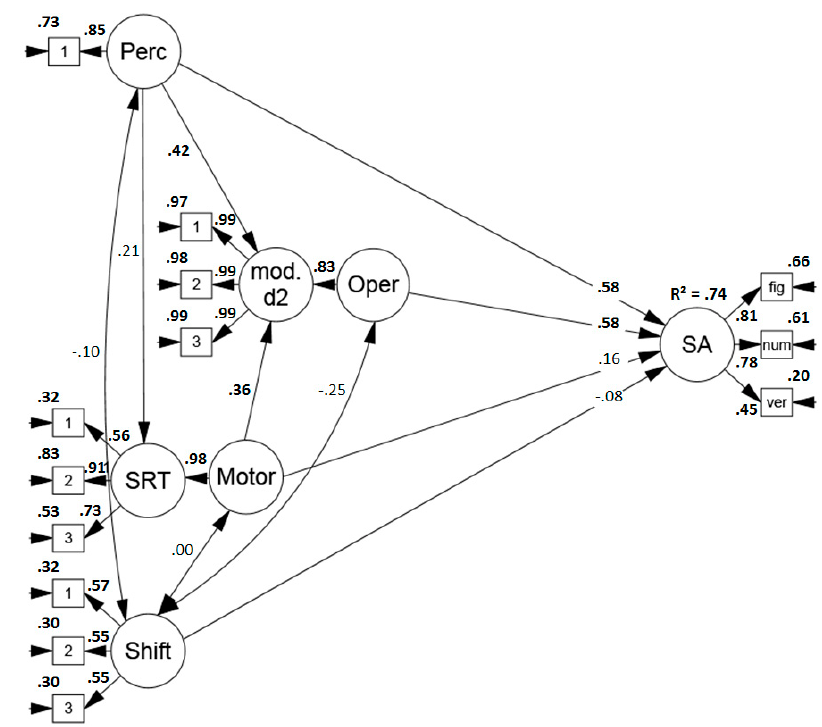
Figure 2. Standardized solution of the model predicting performance in sustained attention tests (convergent validity) based on the proposed process model of sustained attention tests. Significant results are printed in boldface. Perc = perceptual speed, mod. d2 = modified d2, Oper. = operation speed, SRT = simple reaction time task, Motor = motor speed, Shift = item shifting speed, SA = sustained attention, fig = figural task, num = numerical task, verb = verbal task.